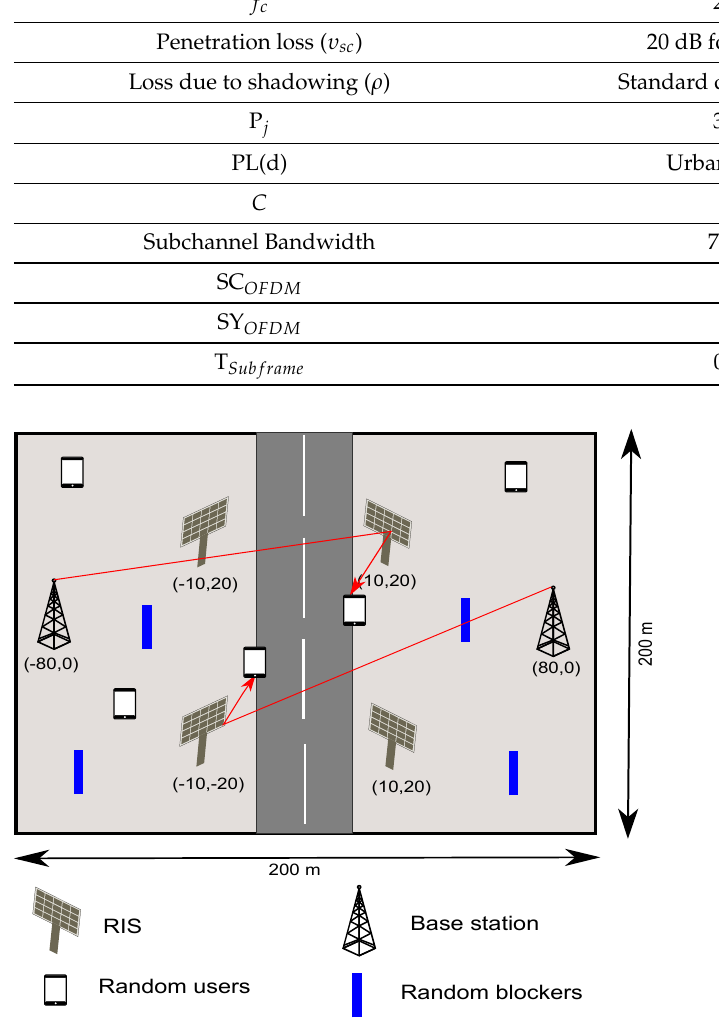
Figure 2. Simulation